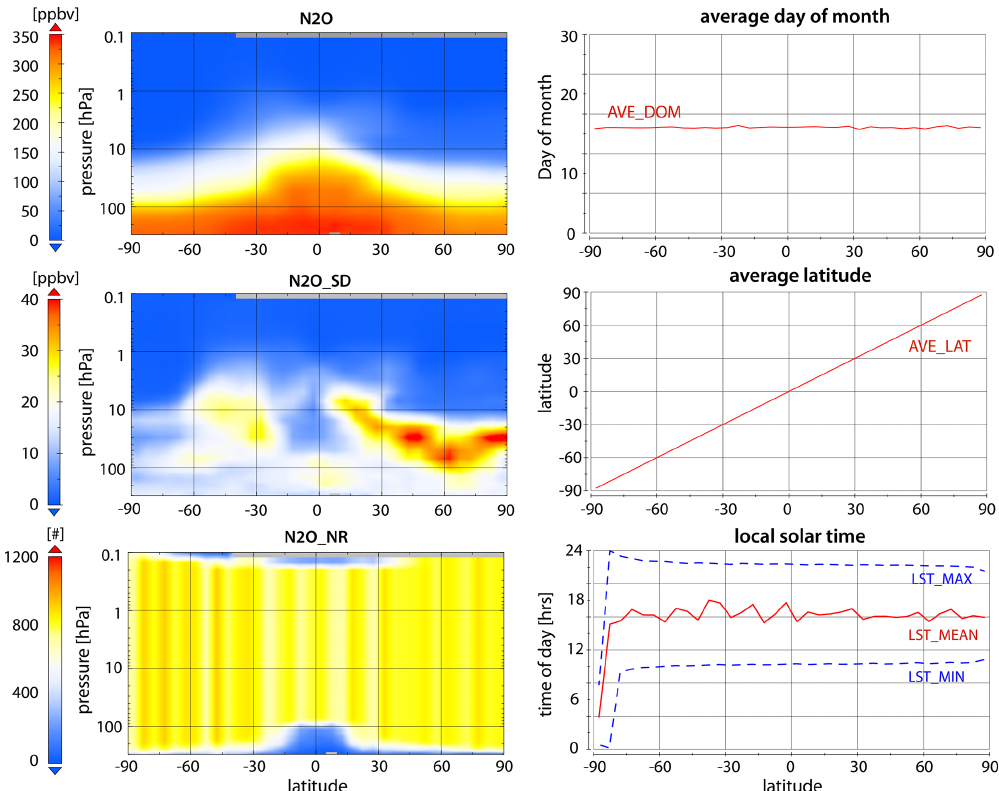
Figure 5. Variables in a typical data file that follows SPARC Data Initiative standards are N 2 O volume mixing ratio, N 2 O standard devi- ation (N 2 O_SD), N 2 O number, average day of month, average latitude, and minimum, mean, and maximum local solar time (LST_MIN, LST_MAX, and LST_MEAN). This example shows April data from the 2008 MIPAS zonal monthly mean file. Table 6. Description of the content included in each of the SPARC Data Initiative data files, here using N 2 O as an example variable. Each file includes the time series of zonal monthly mean data for 1 year. Not-a-number values are filled in with “ − 999.0”. See Fig. 4 for an example. Note that while much effort has been put into applying a consistent file format across the different instruments, some files may still differ from the description